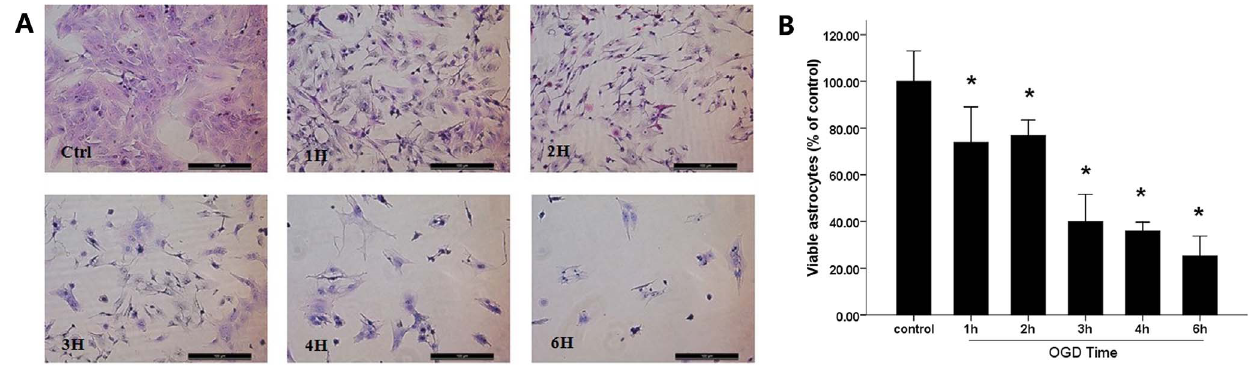
Figure 2. The viable astrocyte exposed to mixed OGD. ( A ) Astrocytes exposed to mixed OGD in the control condition (Ctrl) and for 1 h, 2 h, 3 h, 4 h and 6 h were stained by HE (200 6 ). (B) Counting 5 views for statistical analysis, we found that the amount viable astrocytes decreased as a function of time spent under OGD. (*) indicates a significant difference (P , 0.05) from the control group (Ctrl).